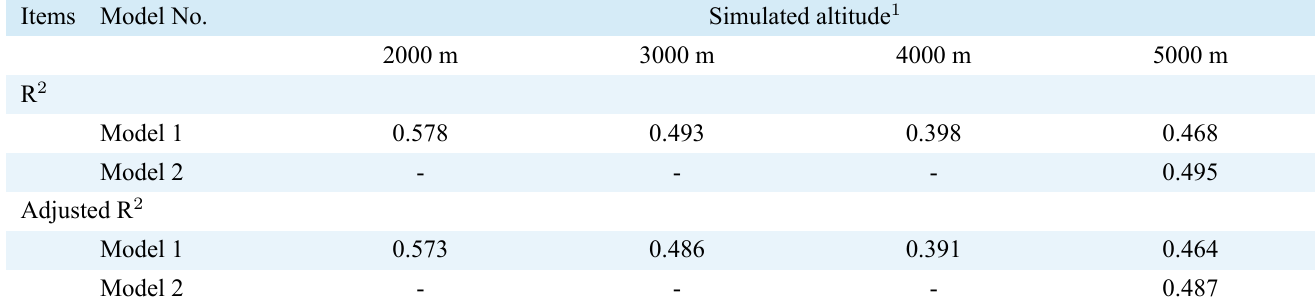
TABLE 7. Coefficient of determination (R 2 ) for each regression model. Items Model